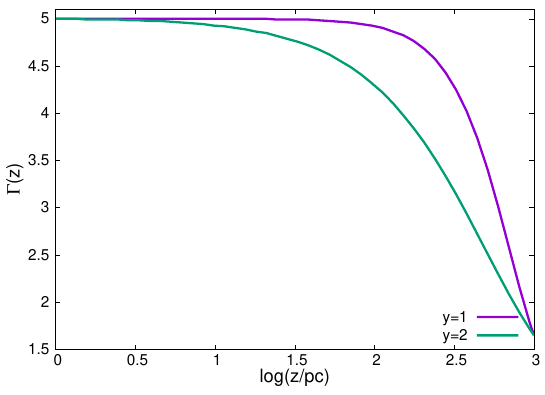
Figure 4. Evolution of the Lorentz factor because of the decel- eration of the jet for the stellar distribution given in Eq. 5 with y = 1 and y = 2.